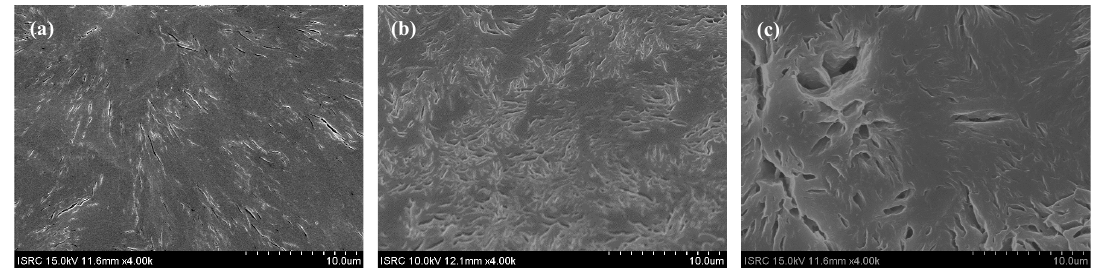
Figure 2. SEM image of surfaces in three different microstructures. ( a ) Untreated surface of control microstructure. ( b ) Roughened surface treated by O 2 plasma treatment. ( c ) Roughened surface treated by X-ray irradiation of 2400 J/cm 3